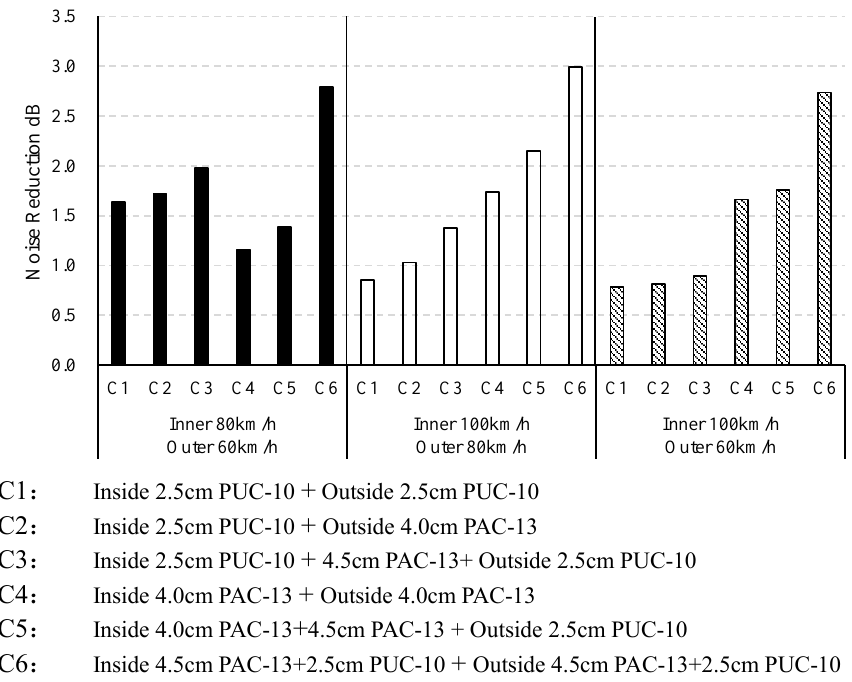
Figure 11. Noise reduction effect of composite pavement at same Figure 11: Noise reduction effect of composite pavement at same speeds.